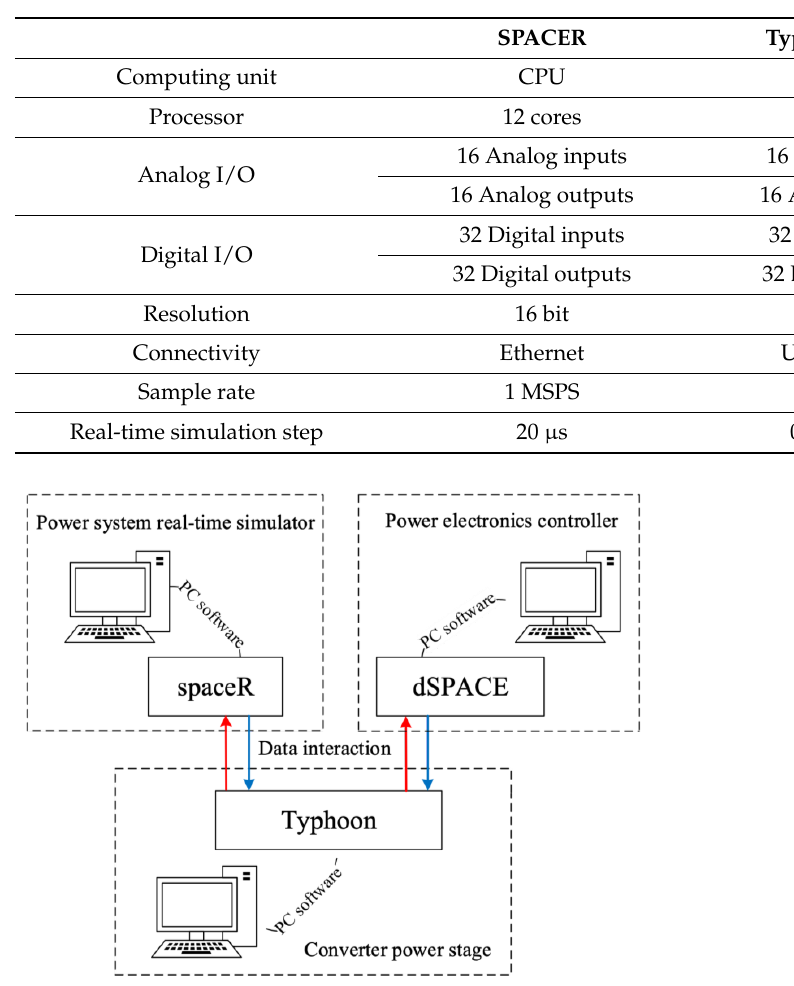
Table 2. Performance Parameters of Real-Time Simulator.